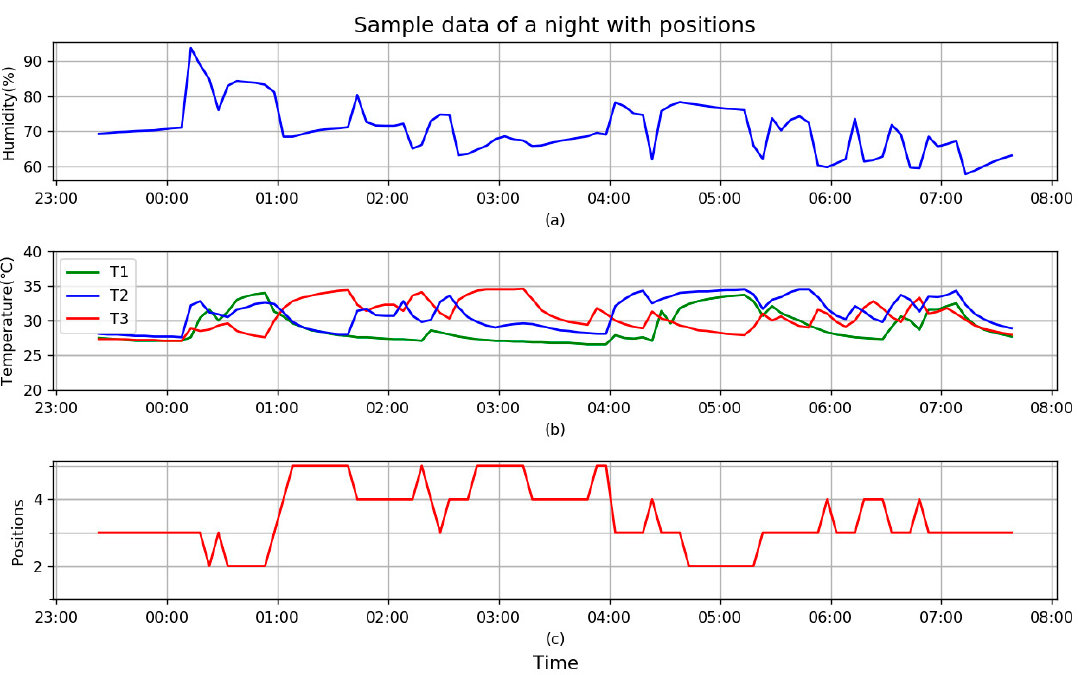
Figure 12. Sample data of sleep with ( a ) humidity H of a night, ( b ) T1, T2, and T3 of a night, ( c ) head-on positions of a night.